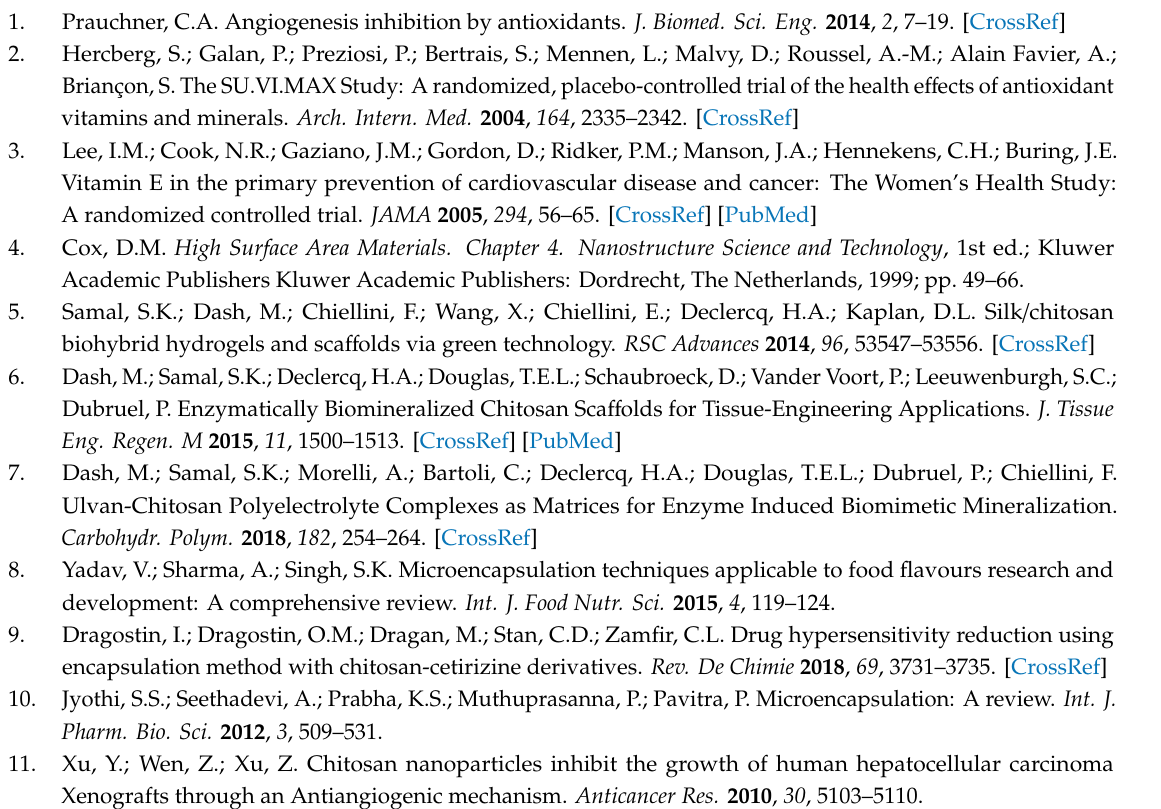
Figure S1: DLS measurements: The size distribution by intensity of chitosan derivatives nanoparticles (a. CLA; b. CLB; c. CLD); Figure S2: Histogram of the number of blood vessels /